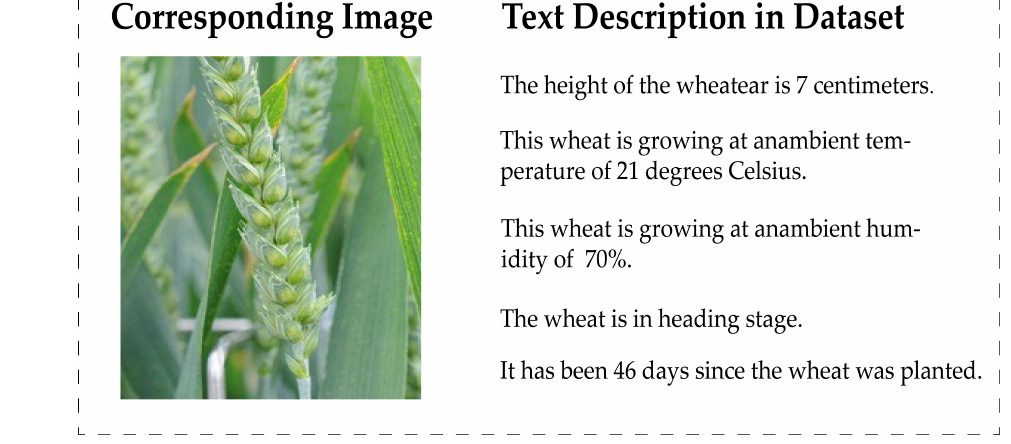
Figure 2. The left side is a captured image, and the right side is a text description of the image in the